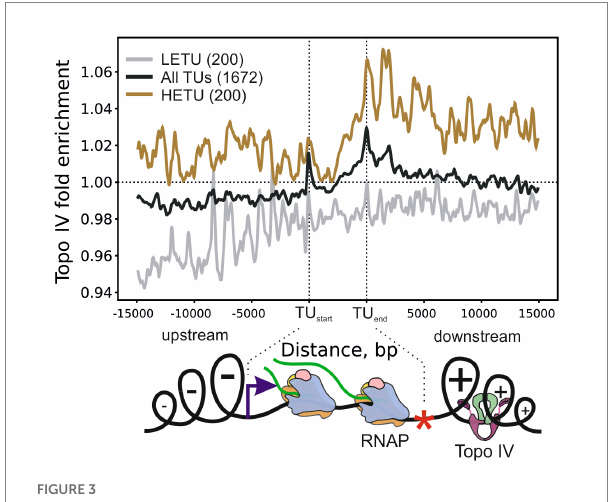
FIGURE 3 Metagene plot showing Topo IV enrichment in TUs, their upstream, and downstream regions. Enrichment is shown for all TUs (black curve), highly expressed (HETU, orange curve), and least-expressed (LETU, gray curve) sets. The number of TUs in each group is indicated in parentheses. Topo IV fold enrichment is given relative to the input sample (+Cfx + IP/-Cfx-IP). Bottom, graphical representation of the Liu and Wang twin-domain model (Liu and Wang, 1987) showing localization of RNAP and Topo IV. Data are shown for the E. coli DY330 parC-SPA